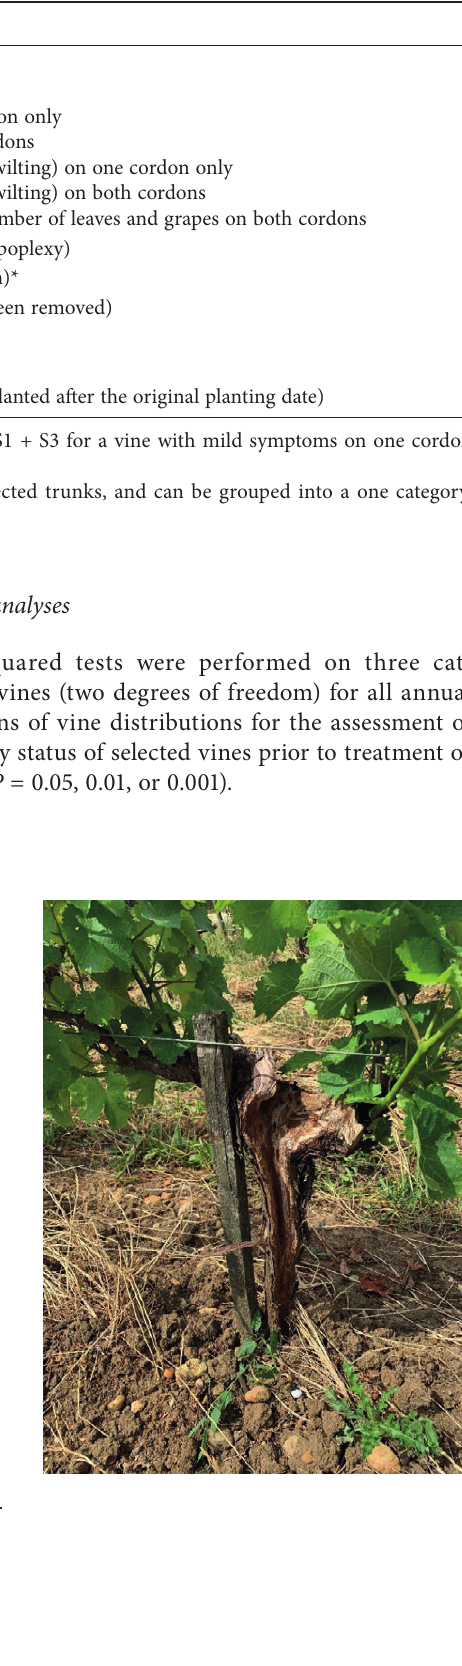
Table 2. Esca disease severity indices used to assess the status of each original ‘Espalier’ grapevine surveyed in this study (from Lecomte et al ., 2018).